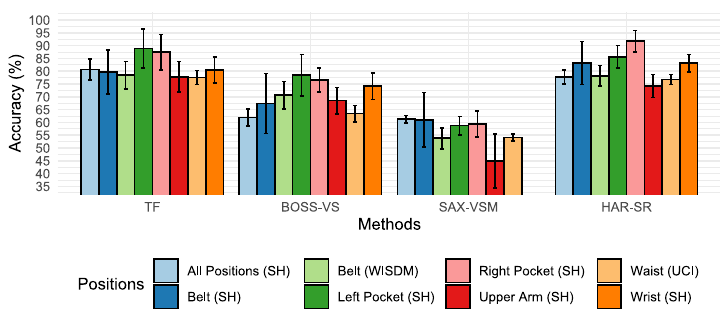
Figure 13. The comparison between the TF, SAX-VSM, BOSS-VS methods and the proposed HAR-SR method. Only the accelerometer sensor was used.